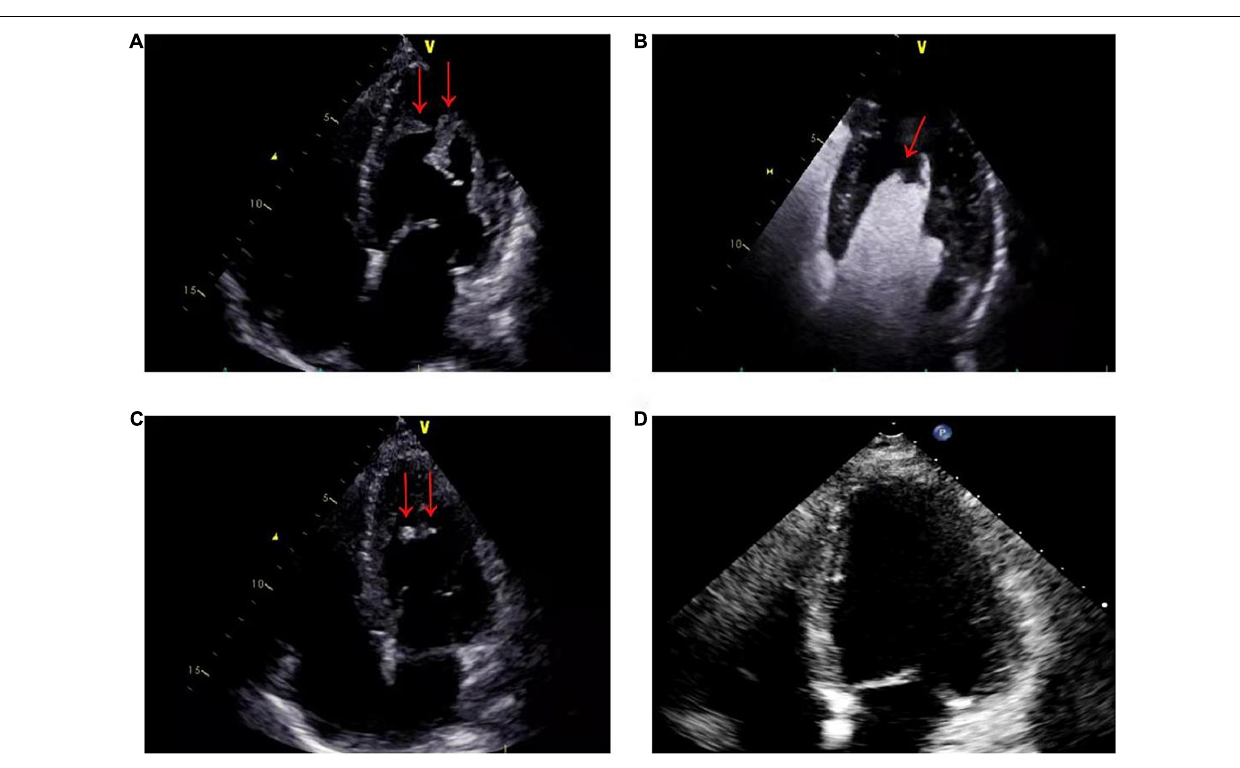
FIGURE 2 | (A) On admission, echocardiography showed that the apex of the left ventricle was filled with a thrombotic mass measuring 3.9 cm × 2.2 cm (arrows). (B) On admission, echocardiographic view after venous injection of an ultrasound contrast agent: thrombus (arrow) at left ventricle apex. (C) Two months after therapy, echocardiography showed a marked reduction in the size of the mass, with a thrombotic mass measuring 6 mm × 13 mm (arrows). (D) Six months after therapy, echocardiography showed that left ventricular thrombus had